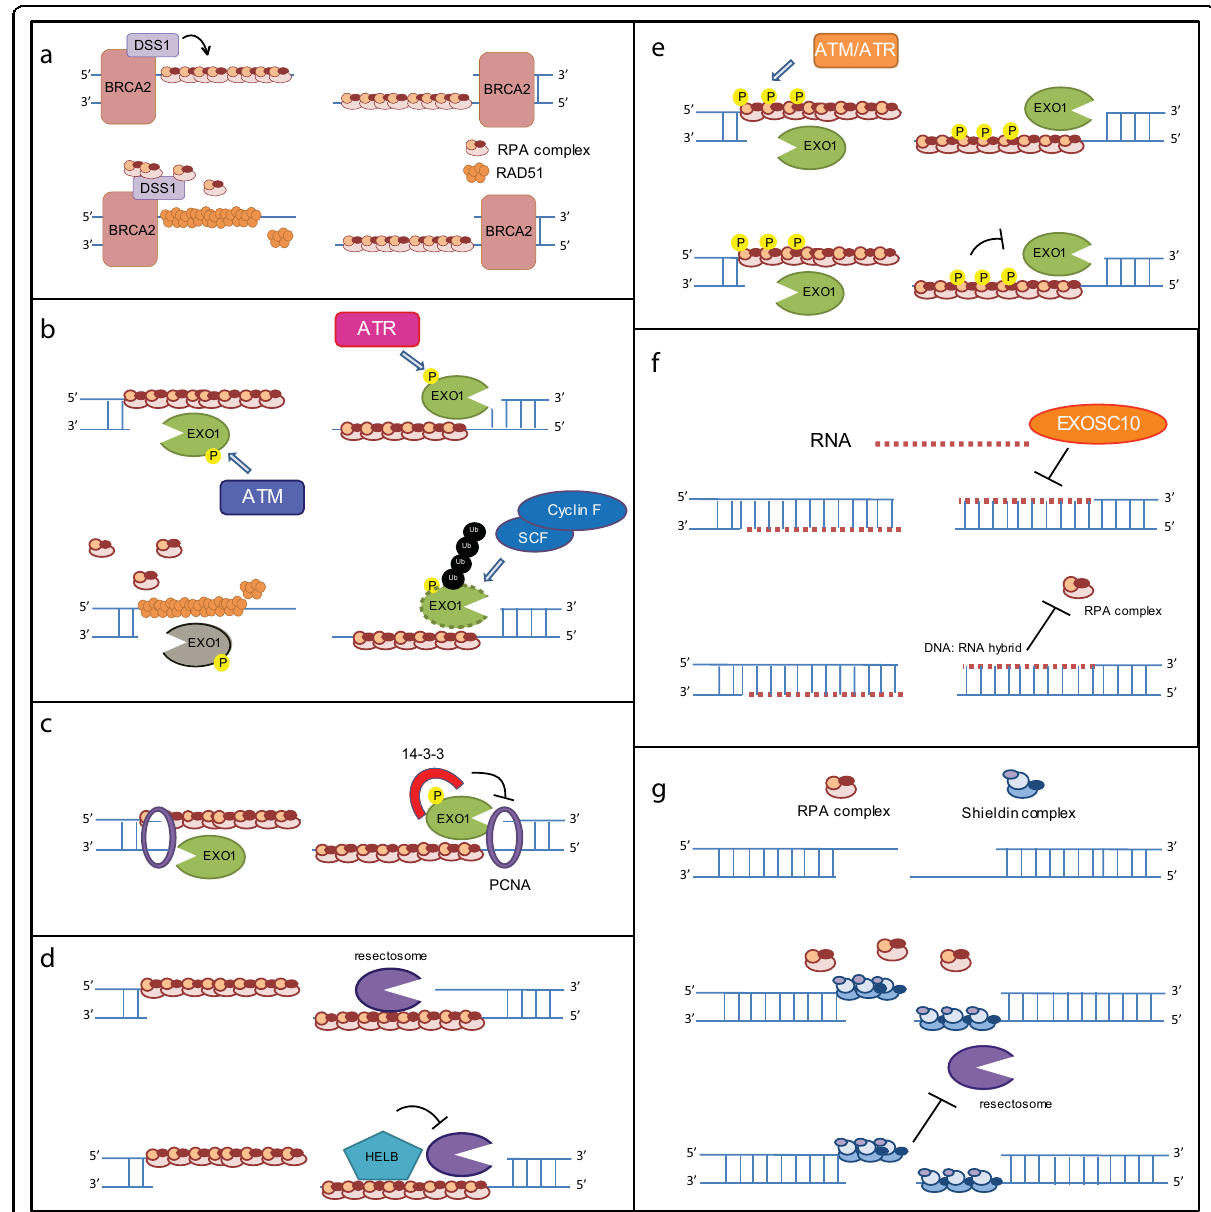
Fig. 2 Current models of DNA end resection termination. The regulatory mechanism of DNA end resection termination by BRCA2-DSS1-RAD51 ( a ), EXO1 phosphorylation/ubiquitination ( b ), 14-3-3 ( c ), HELB ( d ), RPA phosphorylation ( e ), EXOSC10 ( f ) and the shieldin complex ( g